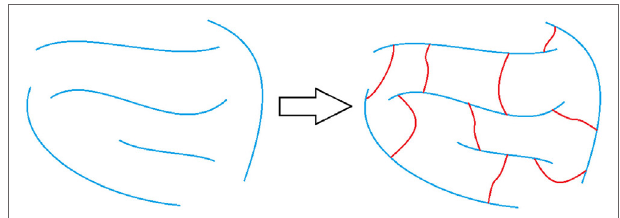
FigUre 3 | Representation of non-cross-linked polymer chains (left) and polymer chains that are cross-linked (right). The blue lines represent polymer chains and the red lines represent the cross-links.